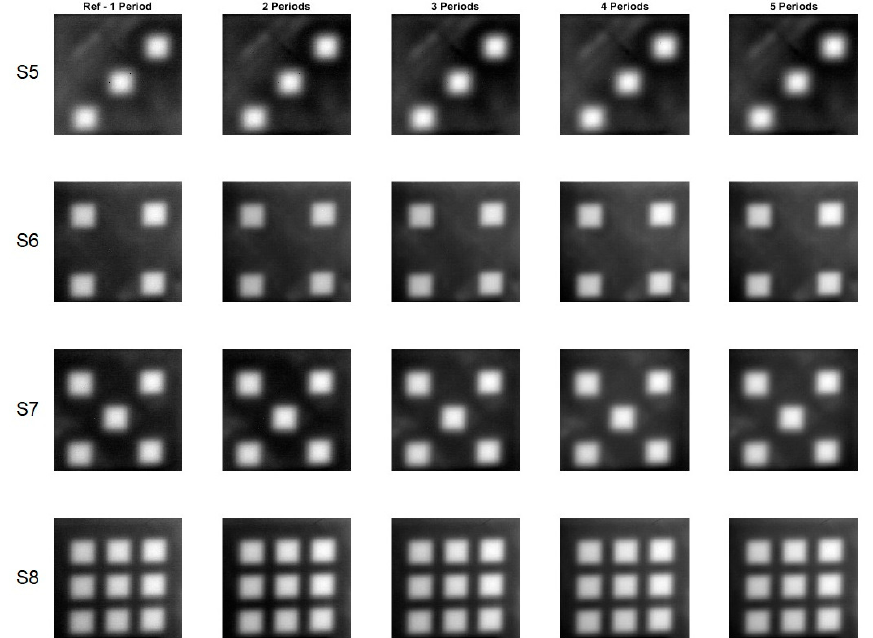
Figure 6. Phase images for the samples with the square cross section defects. A flash lamp was used as a source of excitation. S5–S8 denotes configuration of the square holes.